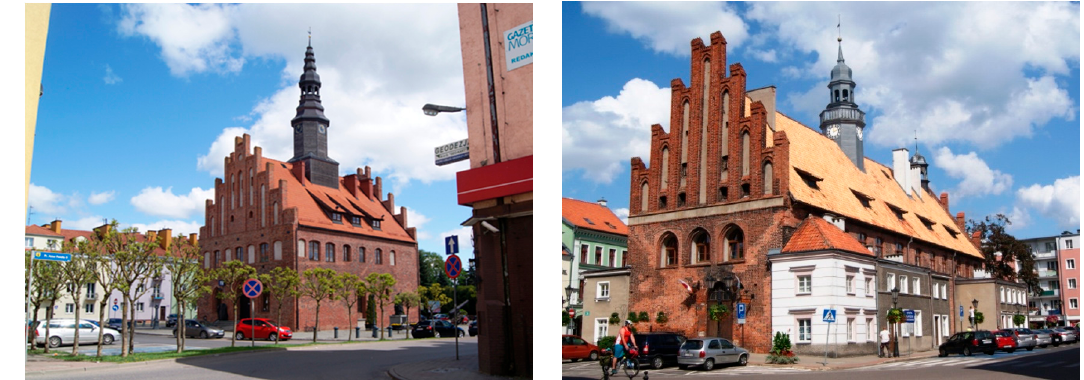
Figure 2. Town halls in Mor ą g and Orneta. Source: own elaboration.